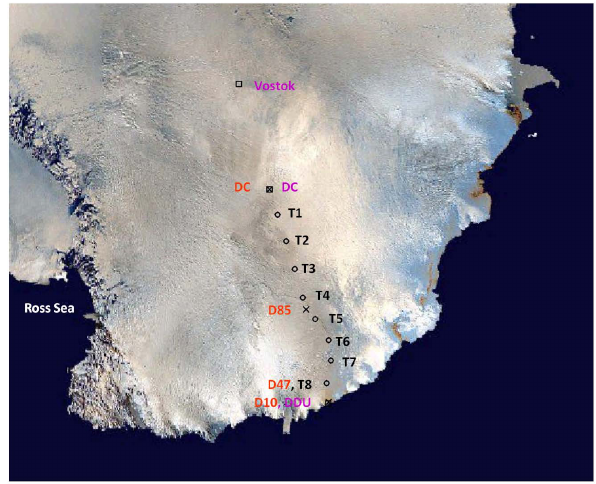
Fig. 6. Map of the logistical traverse between Dome C (DC) and Dumont D’Urville (DDU). The locations of all group T pits (circles) and automatic weather stations D85, D47 and D10 (X) are shown.